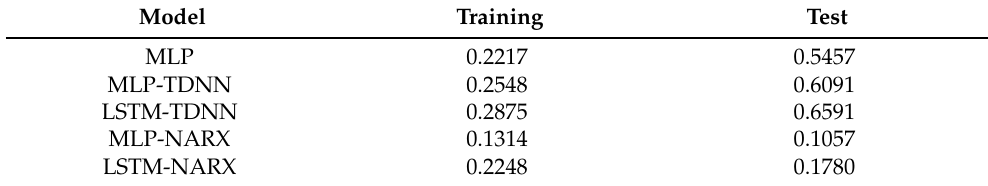
Table 6. The root mean square error (RMSE) on the training and test sets obtained by each model.